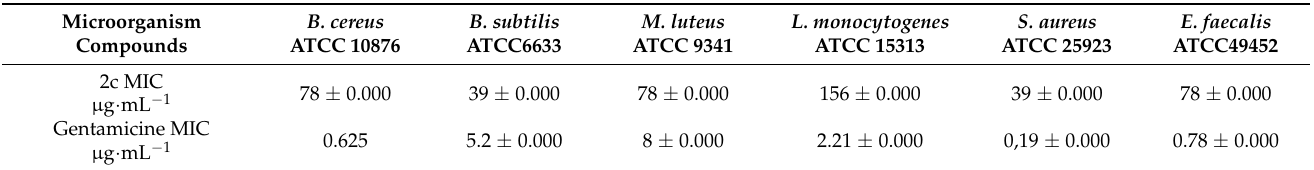
Table 5. MIC results of compound 2c